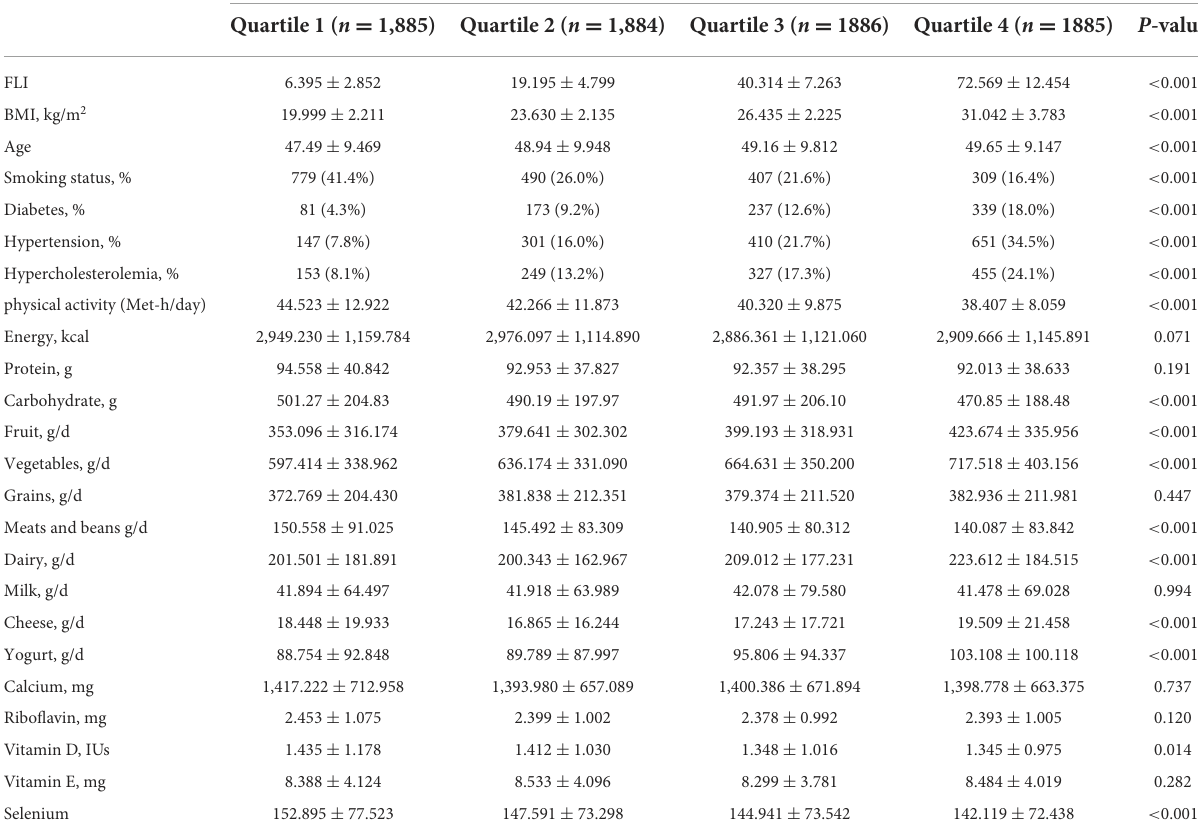
TABLE 2 Participant characteristic and dietary intake according to FLI